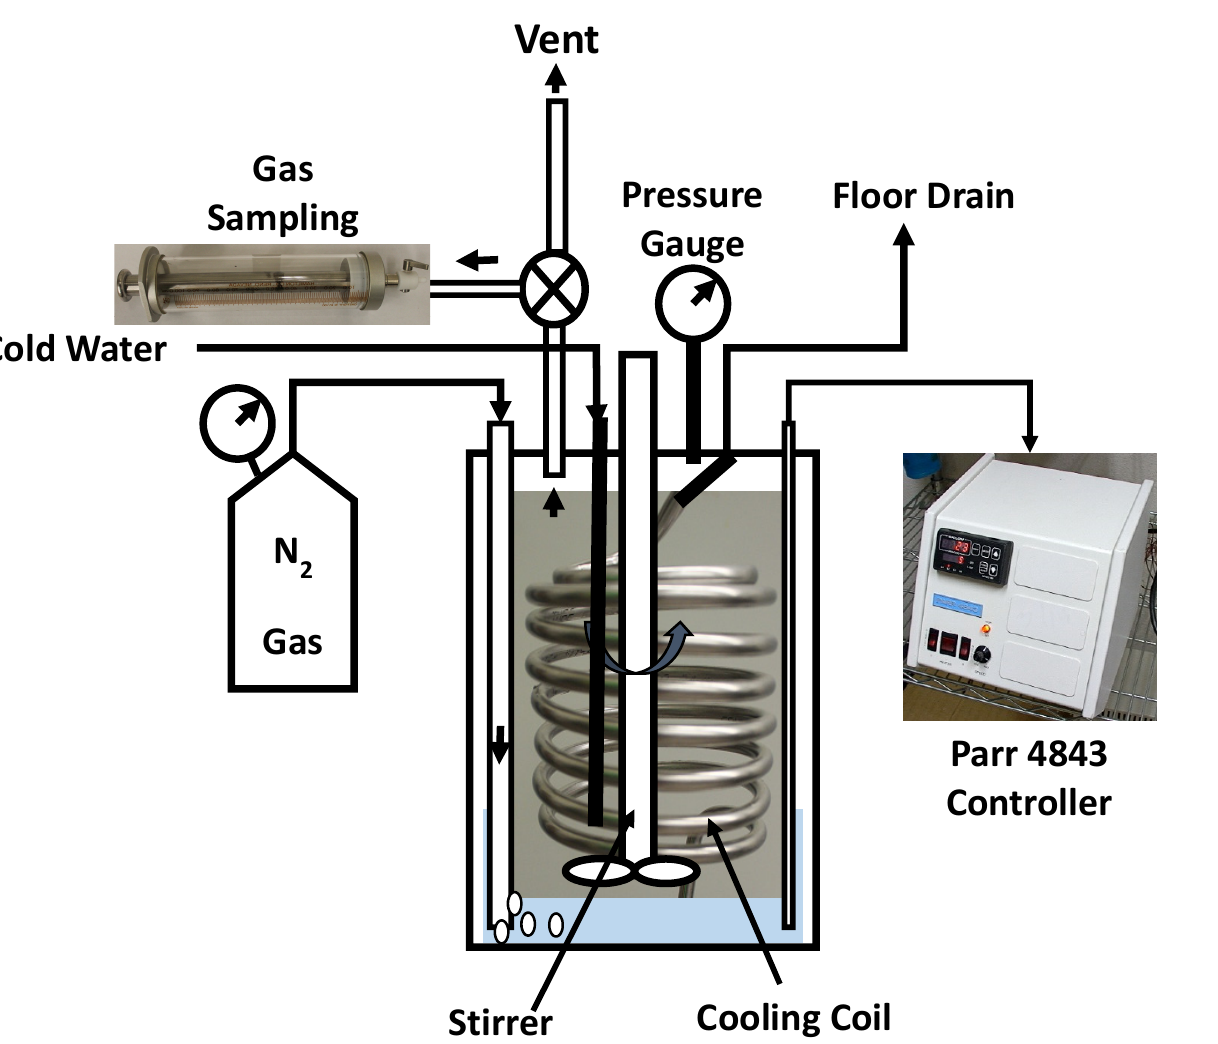
Figure 5. Experimental set-up for hydrothermal carbonization